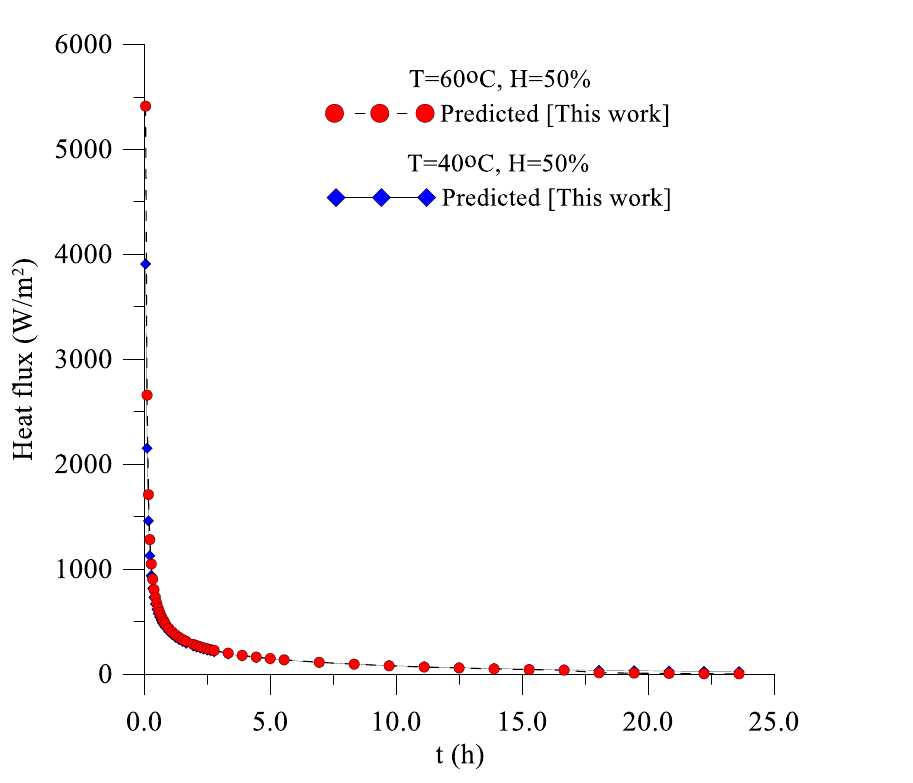
Figure 7. Heat flux on the surface of lentil grain for drying at 40 °C and a relative humidity of 50%.